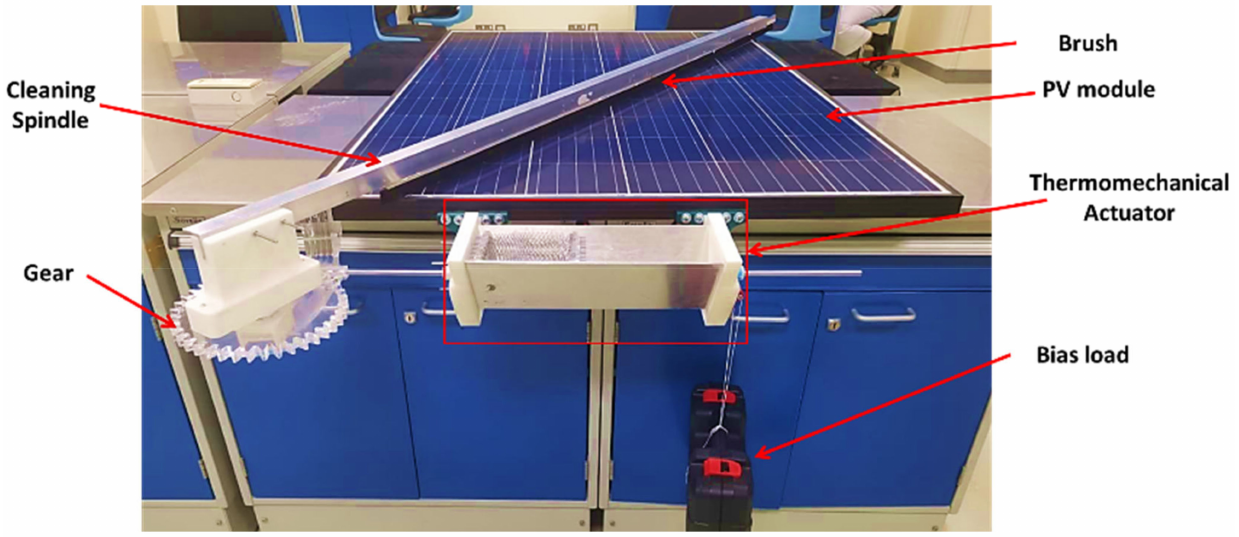
Figure 18. Actual setup for the smart PV cleaning